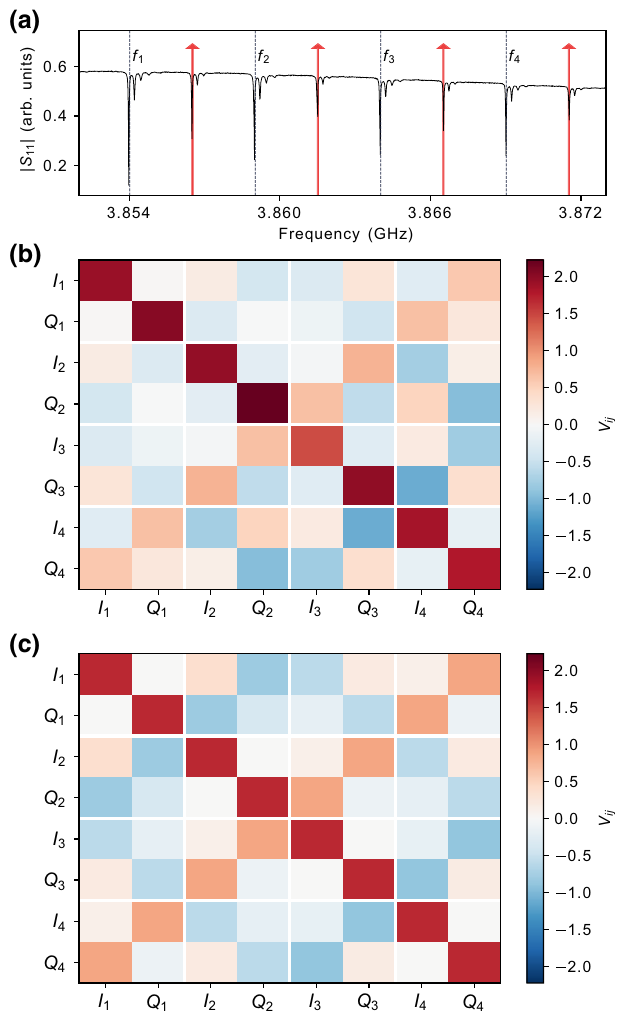
FIG. 4. Multimode covariance matrix. (a) Measurement con- figuration where the solid red arrows indicate the pump fre- quencies. Dashed lines indicate probe frequencies for collecting quadrature noise data. (b) Four-mode quadrature correlation matrix generated from data measured with the pump scheme shown in (a). (c) Theoretical covariance matrix. The analyzed measurement configuration corresponds approximately to that of the experimental data. While in the calculation the pump strength and loss rates are uniform across the modes, the relative pump phases are adjusted to reproduce qualitatively the features of the measured result shown in (b). Fig. 4(c), the correlation features are qualitatively captured by our theoretical model presented in Appendix